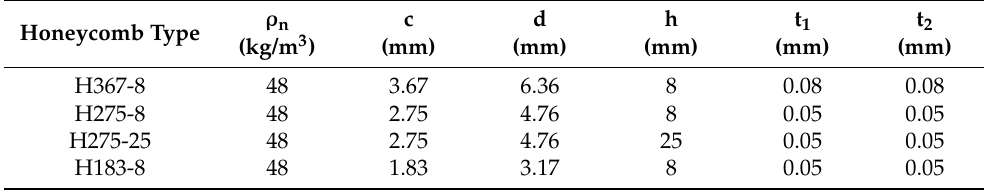
Figure 1. Geometry of a Nomex honeycomb cell. Table 1. Geometrical parameters of the Nomex honeycombs.